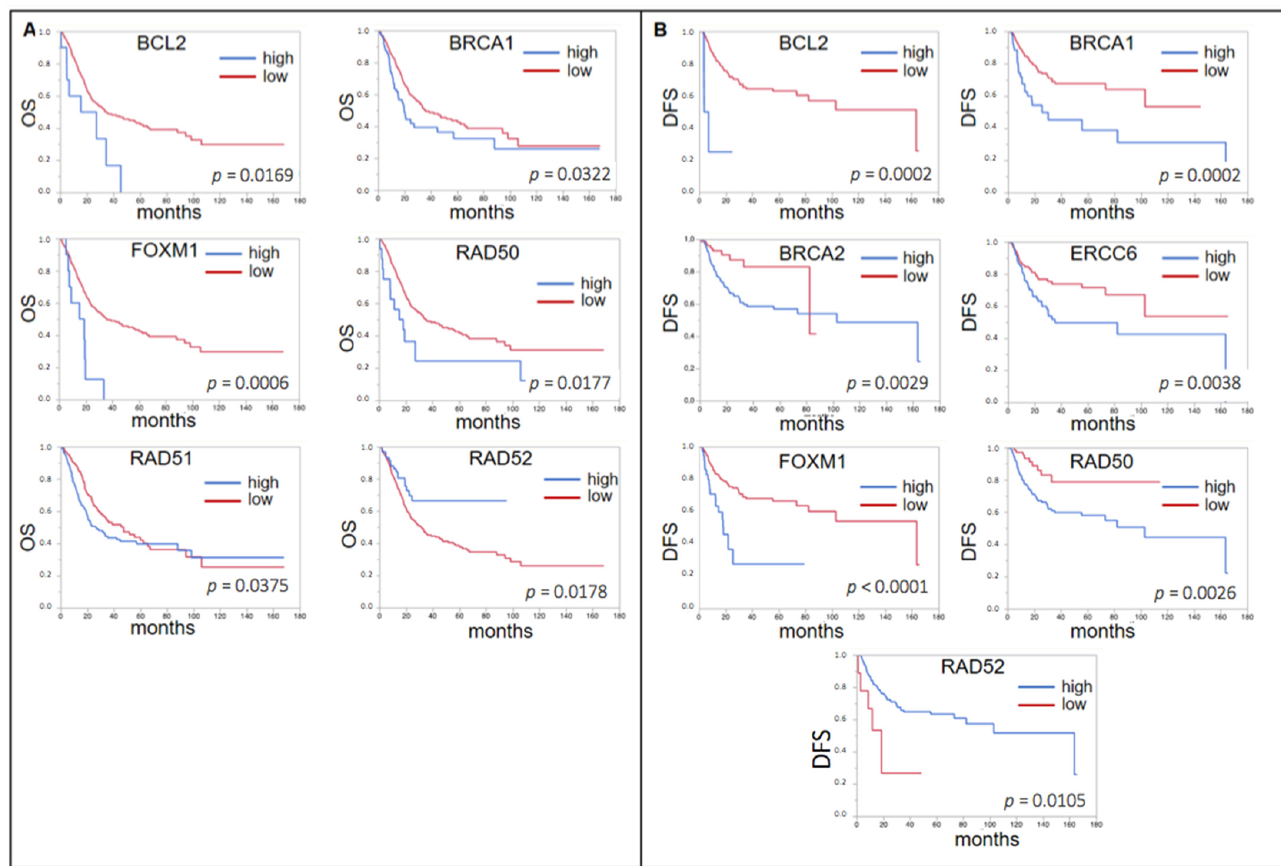
Figure 3. ( A ) Forrest plots of the correlation between RNA expression of DNA damage response genes (DDRG) and OS in the TCGA unselected cohort. ( B ) Forrest plots of the correlation between RNA expression of DDRG and DFS in the TCGA unselected cohort.